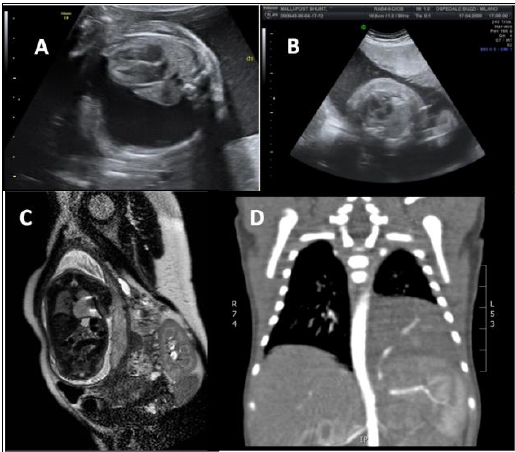
Figure 2: Case prenatally treated with thoraco-amniotic shunt positioning. Fetal US imaging of hydrothorax (A); reduction of